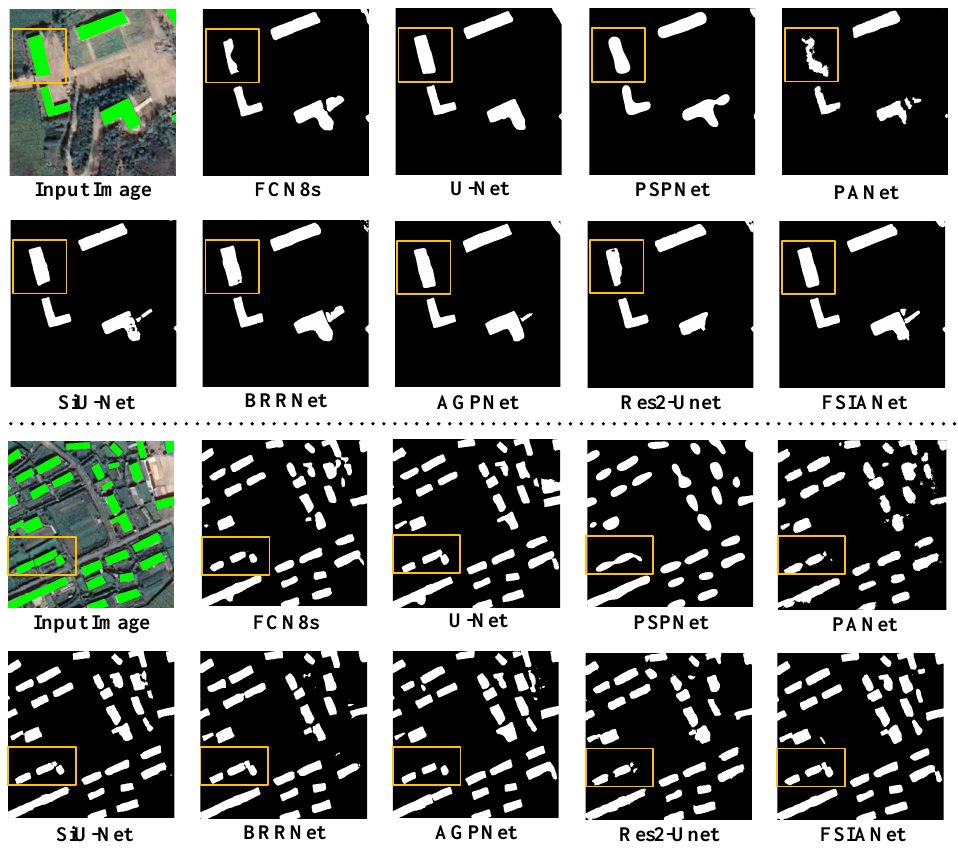
Figure 5. The visualization results of the proposed FSIANet and other comparison methods on the East Asia